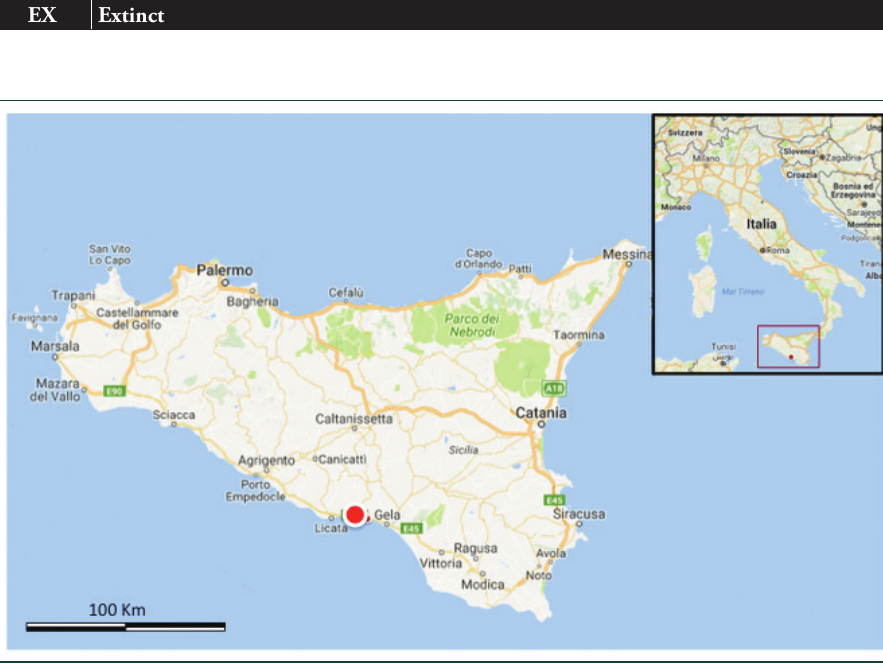
Figure 4. Geographic range and distribution map of Anthyllis hermanniae subsp.